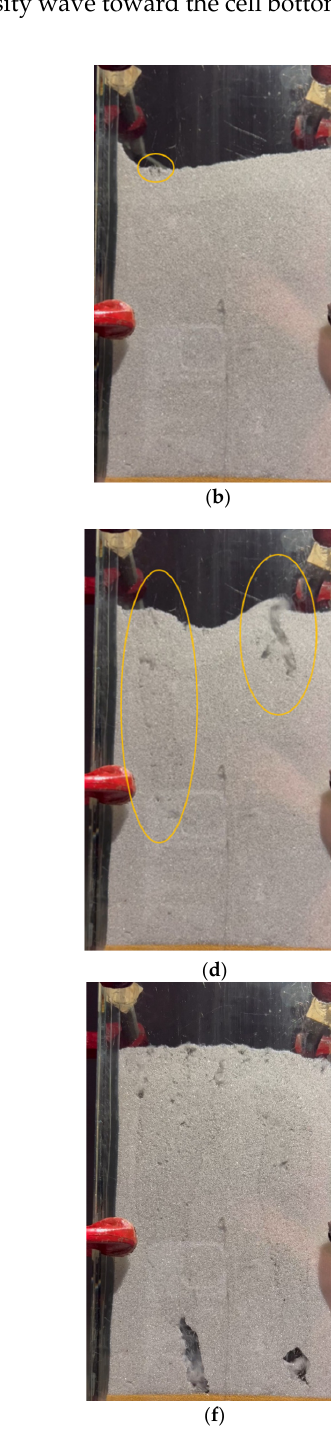
Figure 6. System for laboratory experiments.